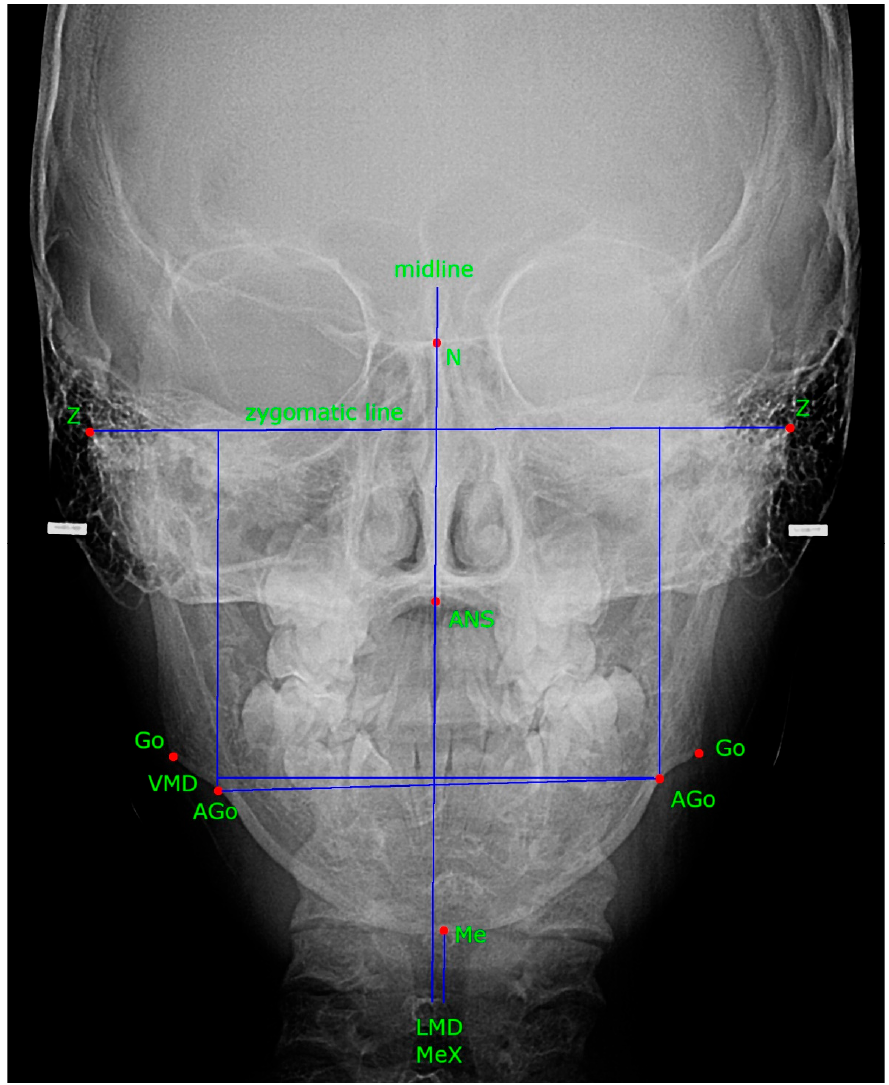
Figure 1. Lateral cephalogram–anthropometric landmarks and lines. S, sella; N, nasion; SNA, the angle between sella, nasion and point A; SNB, the angle between sella, nasion and point B; ANB, the angle between point A, and point B; Go, gonion; Co, condylion; Ar, articulare; Gn, gnathion; Po, porion; Me, menton; 1lci, 1 lower central incisor; NB, nasion point B line; FM, Frankfurt plane; MP, mandibular plane.